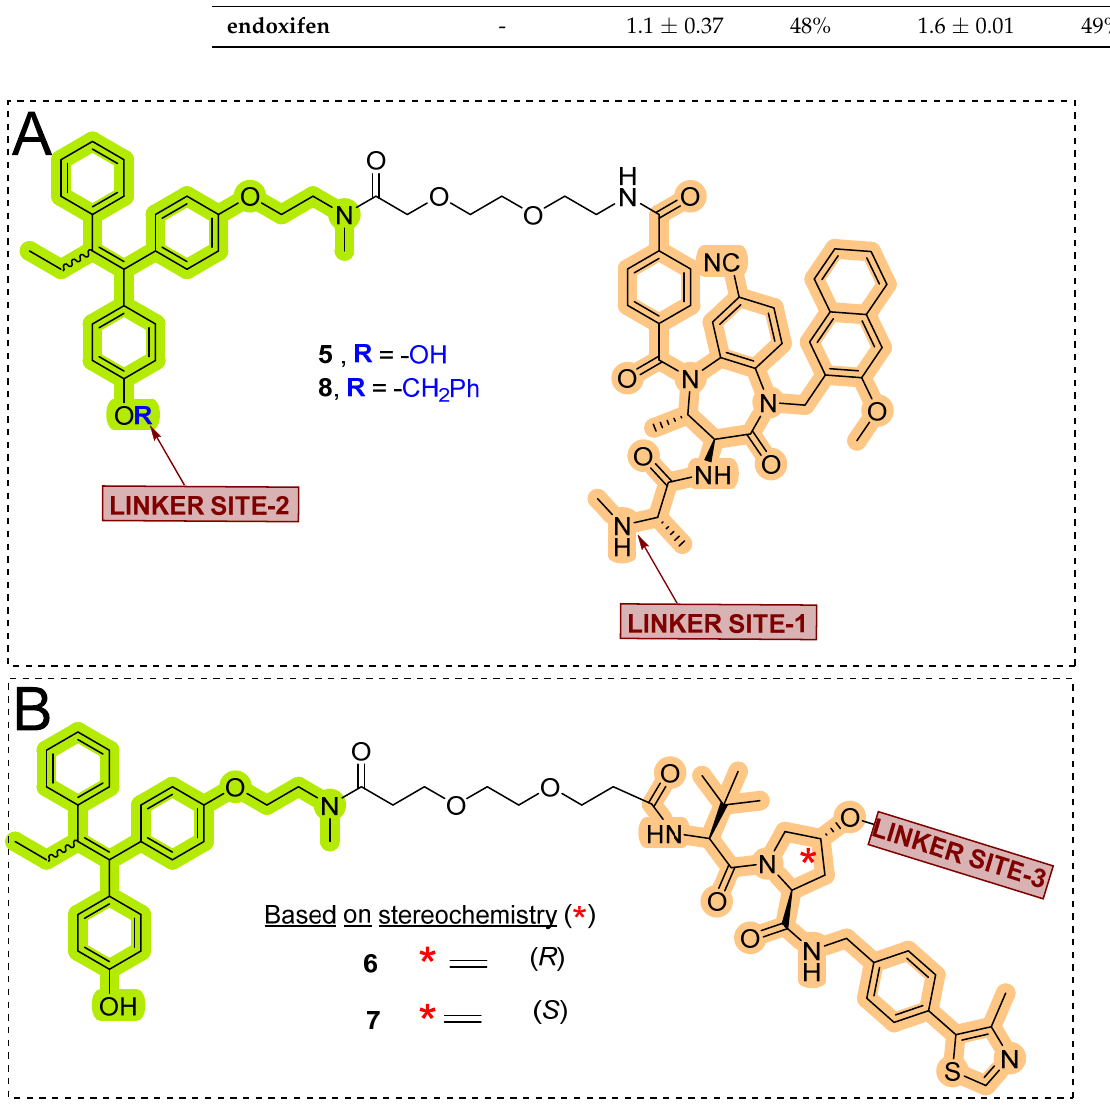
Figure 18. SNIPER and PROTACs used for ADC strategy. ( A ) Linker site-1 and 2 for ADC conjugation. ( B ) Linker site-3 for ADC conjugation.